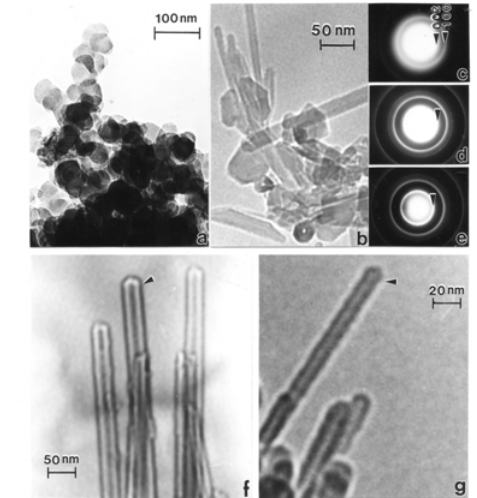
Figure 8: TEM images of a nano-soot PM aggregate (a) and a propane-combustion-generated MWCNT aggregate (b). (c) shows the SAED pattern for (a) white (d) and (e) represent (b) at different exposures. (f) shows a phase- contrast TEM image for chrysotile asbestos nanotubes. (g) shows a (reverse) phase contrast TEM image for natural gas-produced MWCNTs. The arrow illustrates the outer contrast fringe (black for chrysotile in (f) and white for MWCNTs in (g)). This occurs by imaging above or below the focal plane. Note the internal tube contrast also reverses. From Murr, et al. [47].